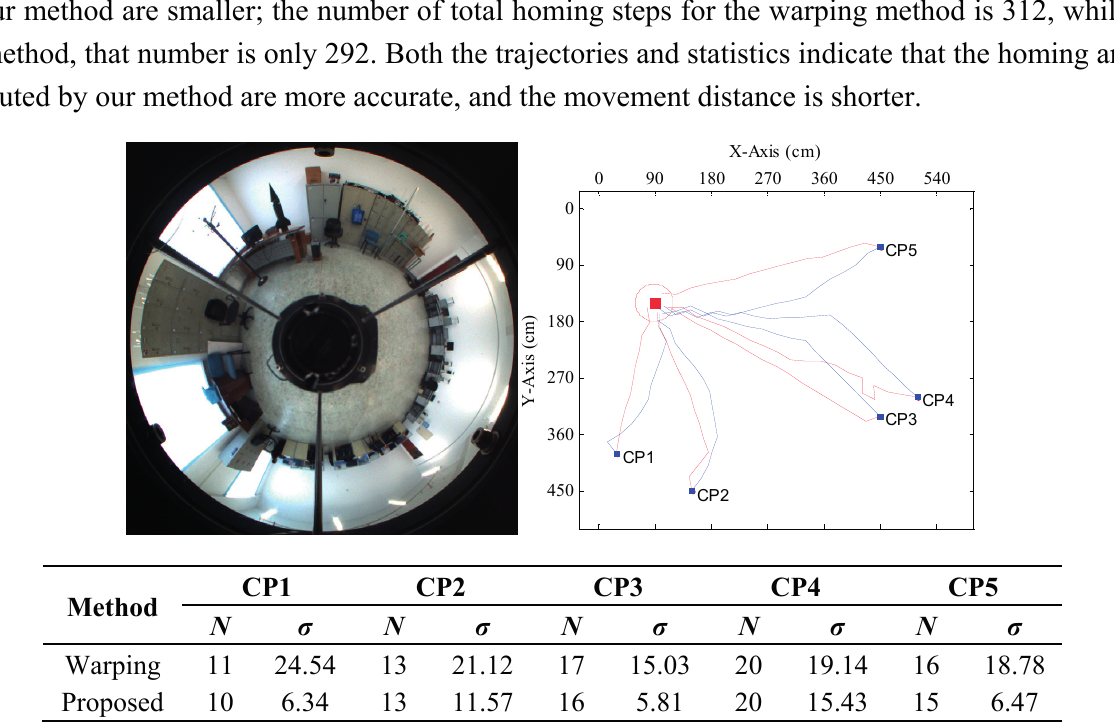
Figure 12. Robot homing Trial 1. Top left: the panorama of the goal position; top right: the homing trajectories for five different current positions; the table below: the number of homing steps and the average angular error for each current position. CP, current